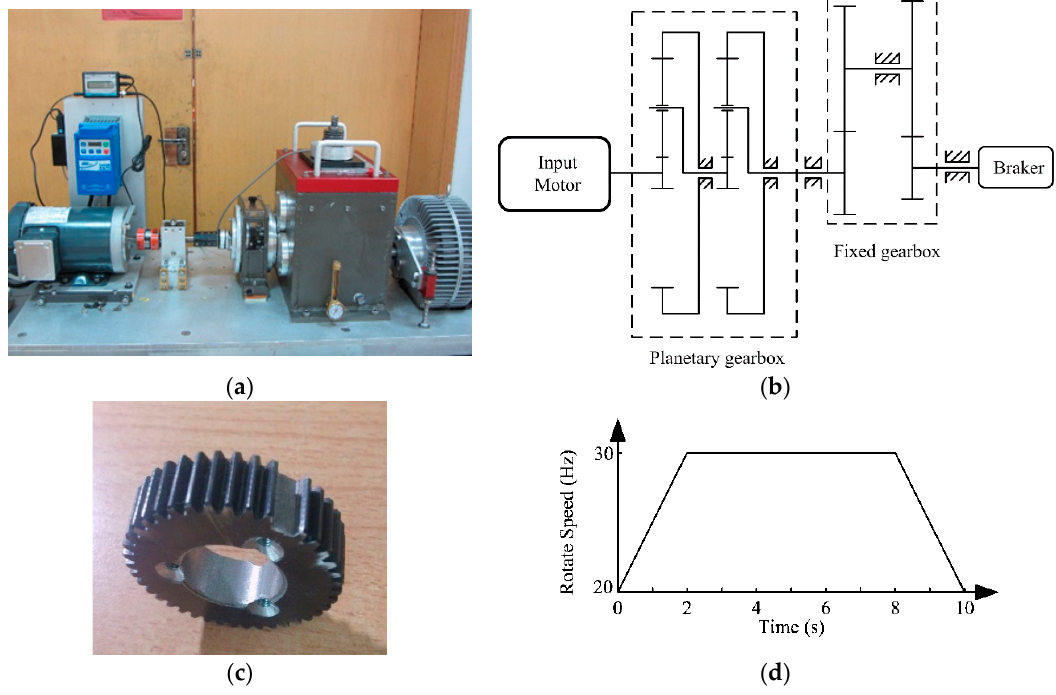
Figure 8. The planetary gearbox test rig: ( a ) Experimental system; ( b ) Schematic diagram of the rig; ( c ) Damage planetary gear missing tooth; ( d ) Input motor speed curve.